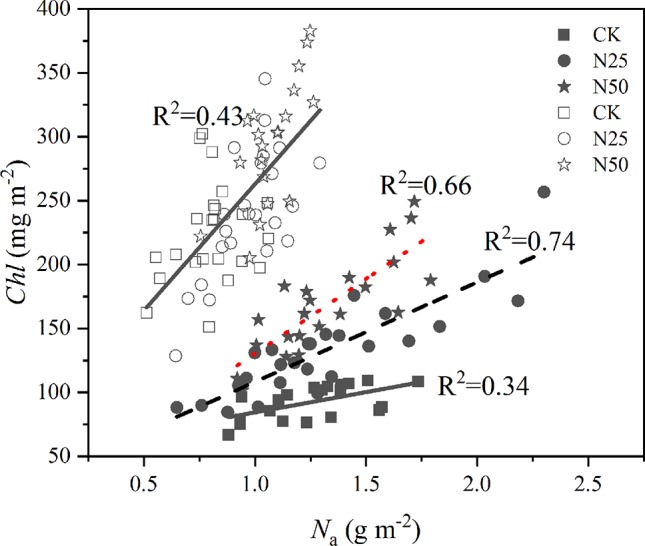
The concentration of Chl per unit leaf area as a function of the corresponding measures of leaf N (N
a). Open symbols represent Cyclobalanopsis glauca, the closed symbols represent the data of Liquidambar formosana. p < 0.01 for linear regressions for each species and treatment.